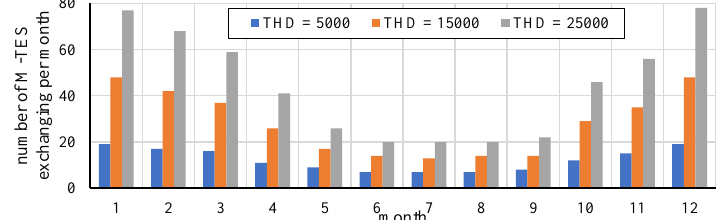
Figure 8. Number of M-TES exchanges (M-TES.EX) during each month of the year for different value of total heat demand (THD): 5000, 15,000 and 25,000 kWh/year.